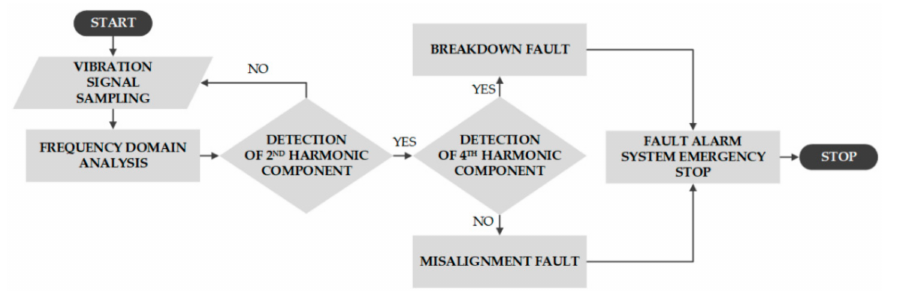
Figure 18. Flowchart of the proposed method for the position sensor fault diagnosis through vibration